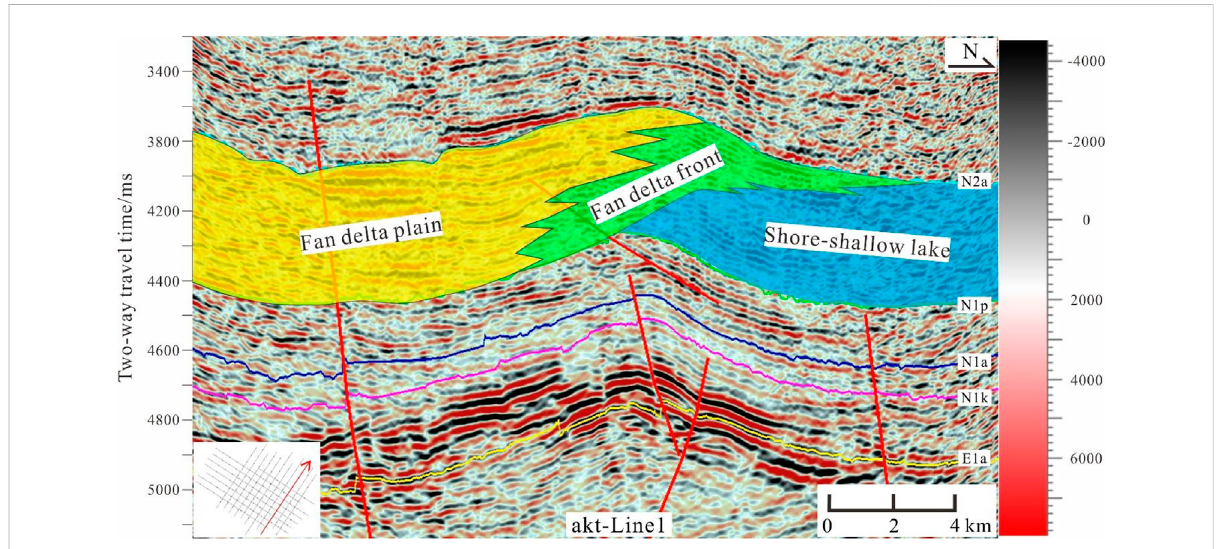
FIGURE 12 Sedimentary model pro fi le of the Pakabulake Formation in the Aketao structural belt.